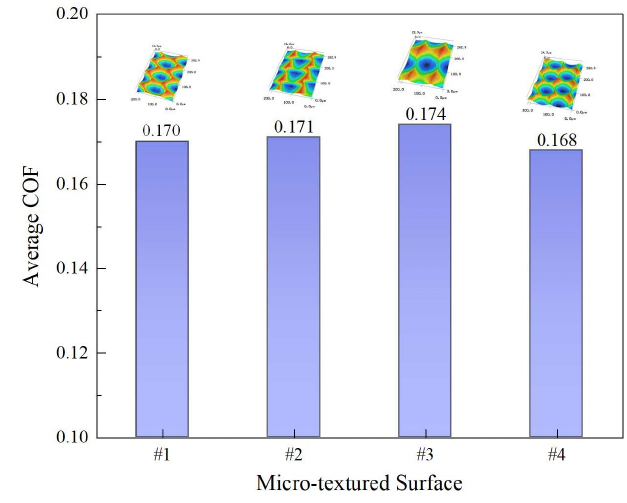
Figure 13. Average COF of the four micro-textured surfaces.